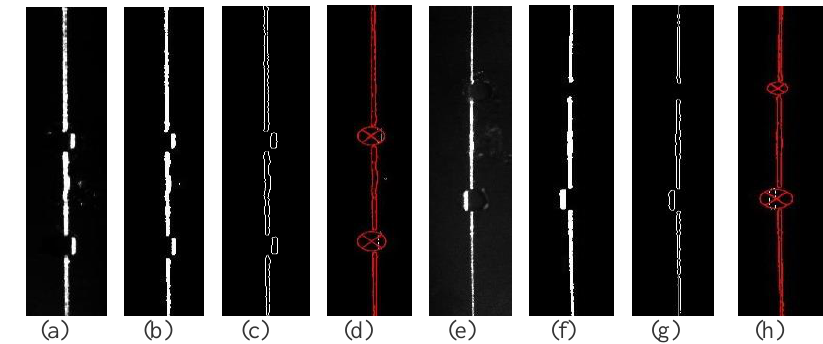
Fig. 9. Same detection results of two stereo cameras after adjusting position and angle of C_2.